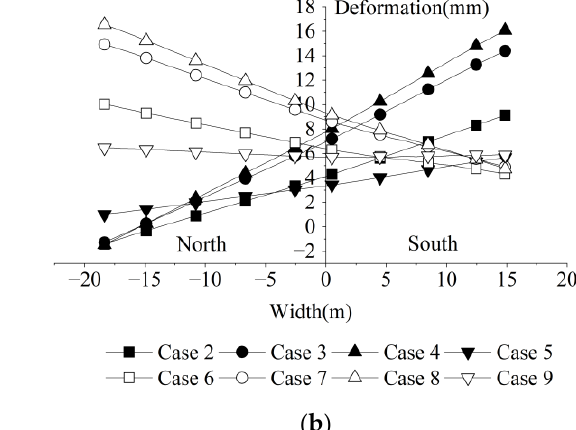
Figure 11. Lateral deformation of structural wall subjected to asymmetric construction: ( a ) northern wall, ( b ) middle wall and ( c ) southern wall (unit: mm).